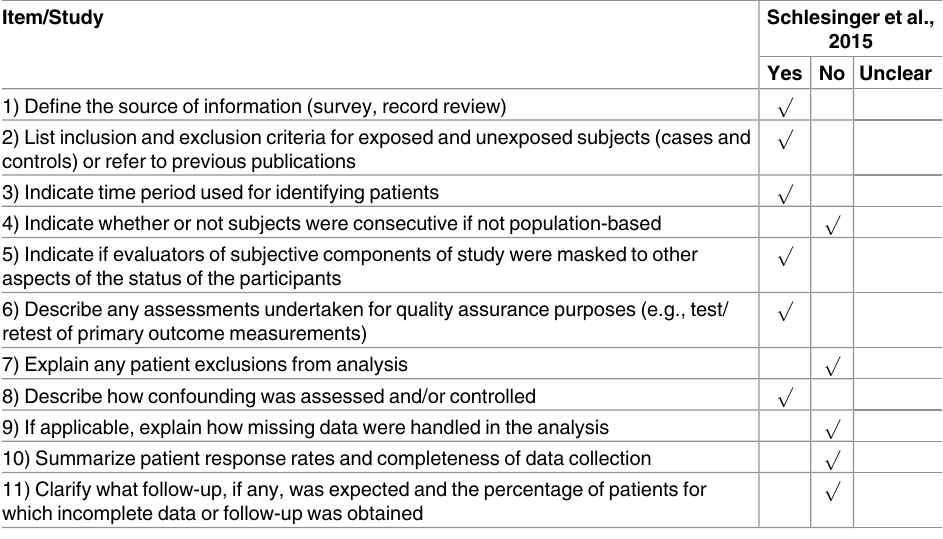
Table 3. Risk of bias assessment of cross-sectional